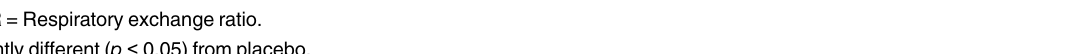
Note : RER = Respiratory exchange